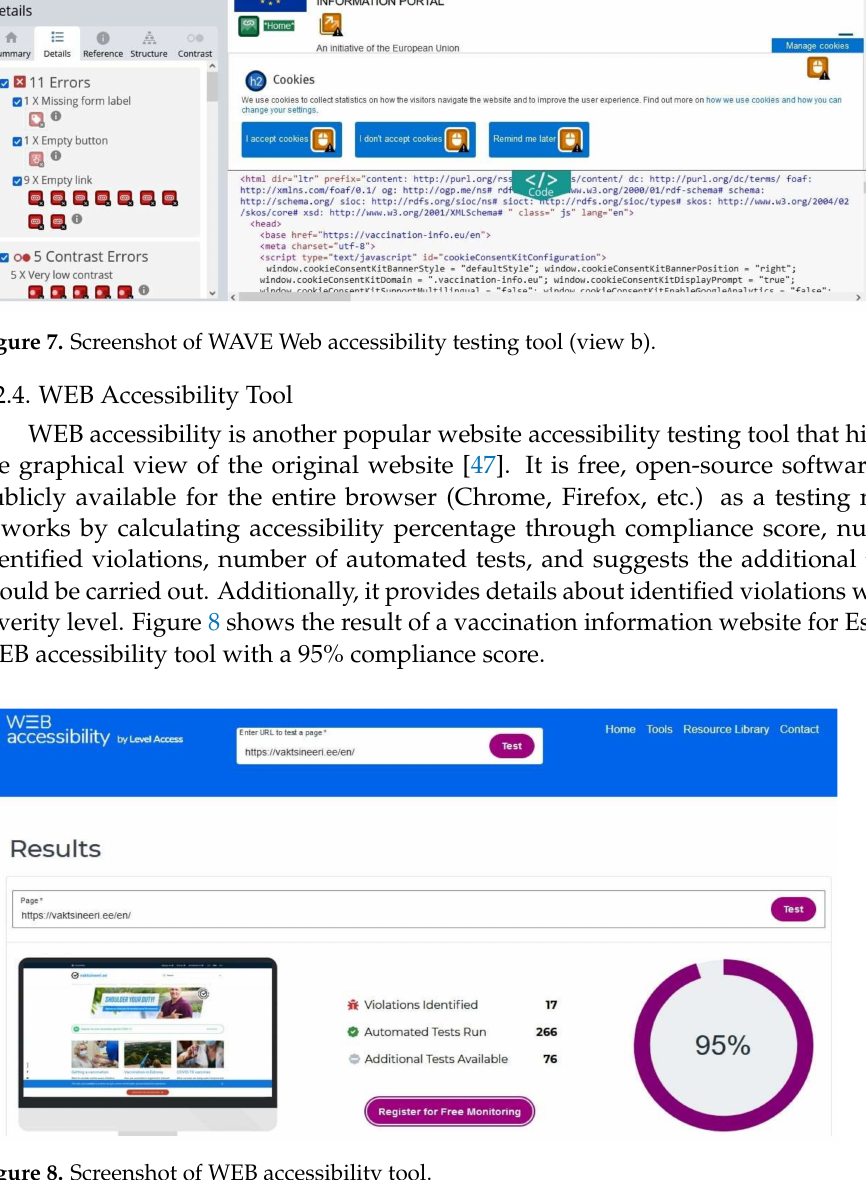
Figure 8. Screenshot of WEB accessibility